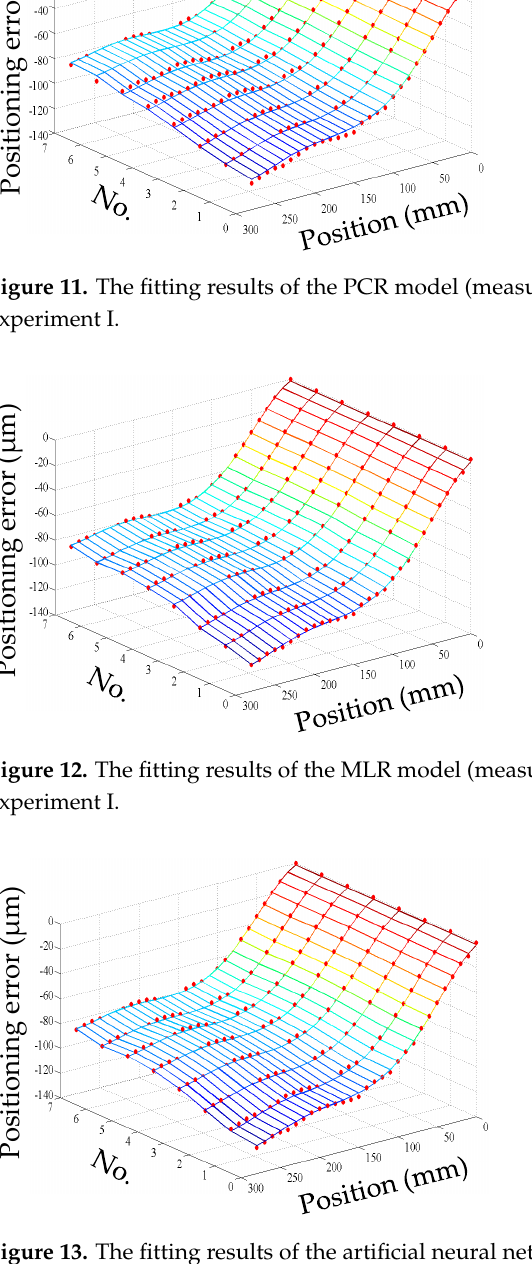
Figure 14. Residual error in experiment I: ( a ) residual error of PCR model; ( b ) residual error of MLR model; ( c ) residual error of ANN model. Table 20. Fitting results of three models. Model